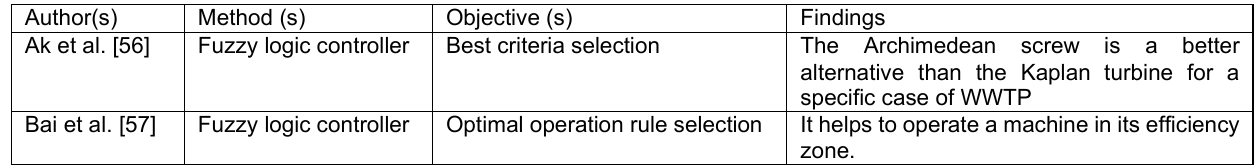
Table 5. Summary of the application of AI in policy and feature selection